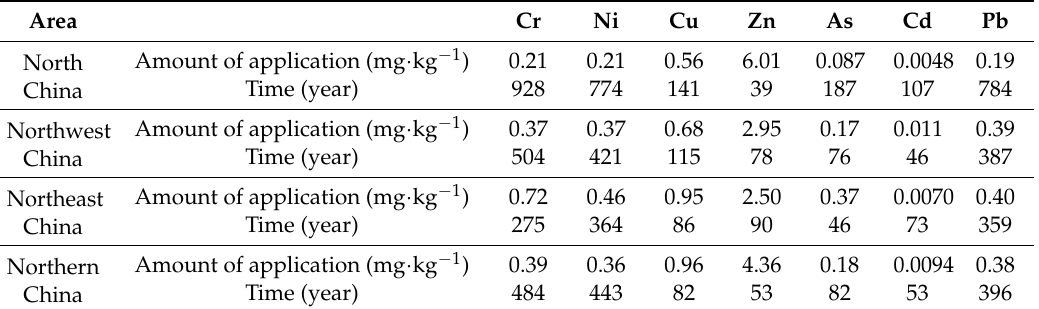
Table 7. Input of trace metals and time needed to double the trace metal concentrations of soil from its background levels in the research